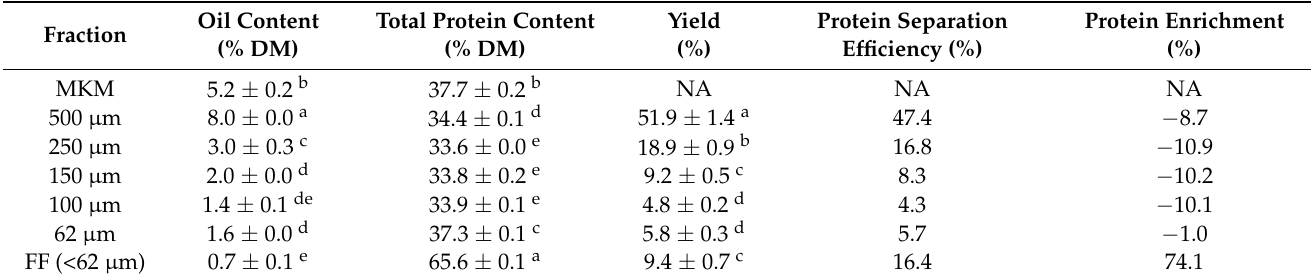
Table 3. Composition of the fractions and dry fractionation performance parameters after the representative sieve fractionation of macauba kernel meal ( A. aculeata ) from hydraulic pressing, milling to 1 mm, and solvent extraction with hexane (HHA 1